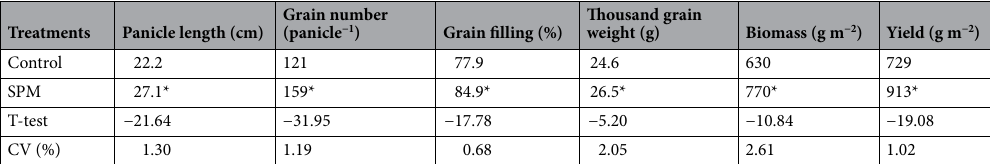
Table 7. Effect of spermine on panicle length, grain number, grain filling, thousand grain weight, biomass and yield in IADA BLS. T-test was performed at P ≤ 0.05. *: Significant at P ≤ 0.05. IADA BLS: Integrated Agricultural Development Authority Barat Laut Selangor. CV: Coefficient of variation.